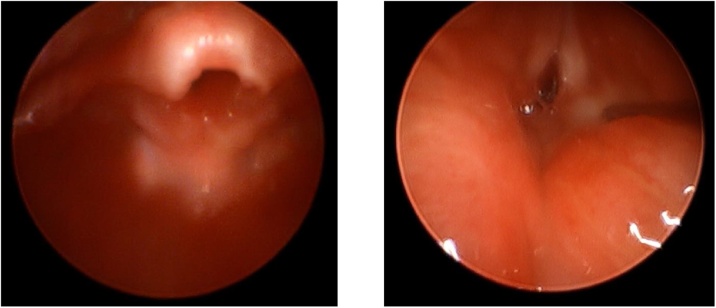
Images- Direct Microlayngoscopy and Rigid Bronchoscopy Showing the Subglottis with 99% Soft, Circumferential Stenosis with Moderate Proximal/Suprastomal Collapse.